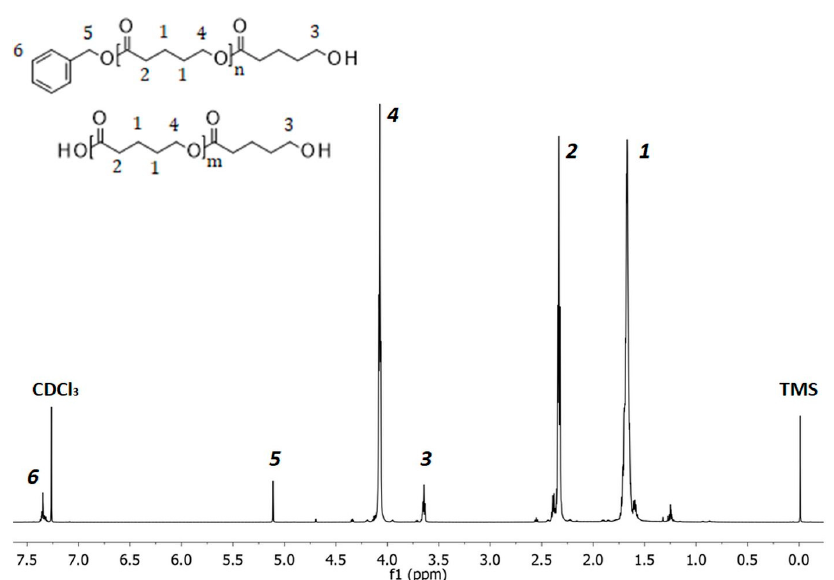
Figure 1. Proton nuclear magnetic resonance ( 1 H ‐ NMR) spectrum of poly( δ ‐ valerolactone) oligomers (Sample 1, Table 1).